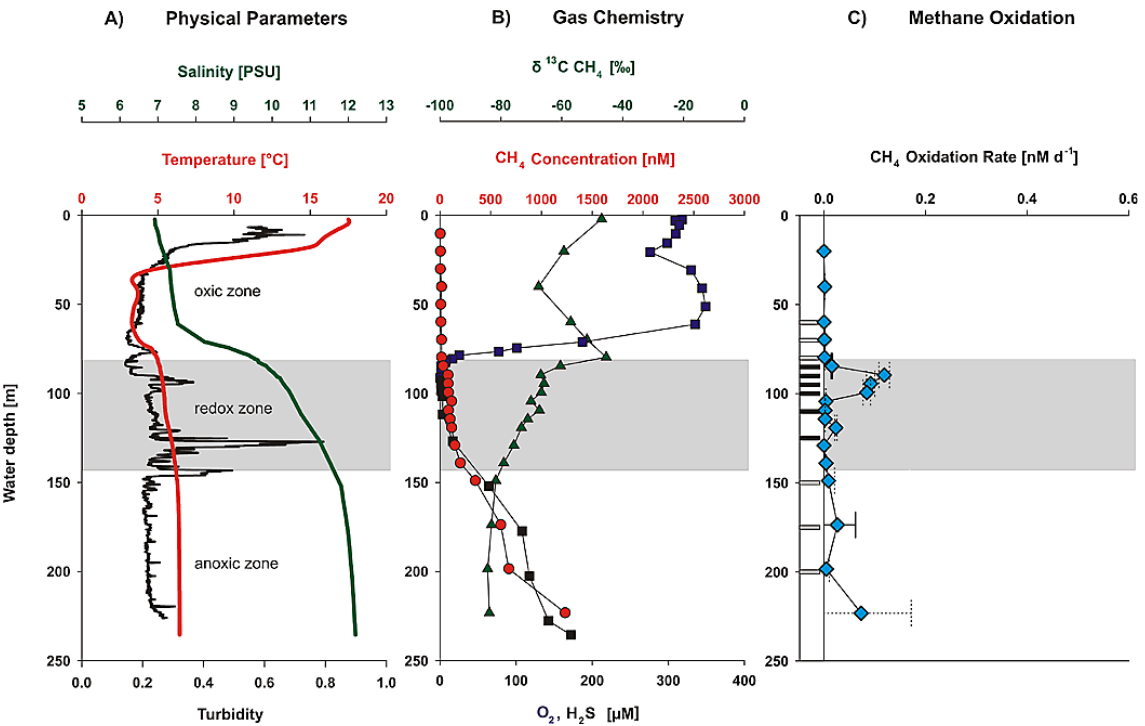
Fig. 2. Gotland Deep. (A) Vertical profiles of salinity (green), temperature (red) and turbidity (black); (B) oxygen (blue squares), hydrogen sulfide (black squares), methane (red circles) and δ 13 C values of methane (green triangles); (C) methane oxidation rates (light-blue diamonds) and sampling depths of pmoA gene expression analysis (black bars denote the occurrence and white bars the absence of active type I methanotrophs). To obtain the standard deviation ( s ) for methane oxidation rates, triplicates were taken in three water depths (70, 85, 175m). The solid error bars indicate the standard deviation from these triplicates, whereas the dashed error bars show the standard deviation calculated from these triplicates for the single water samples. The redox zone is indicated by the gray-shaded